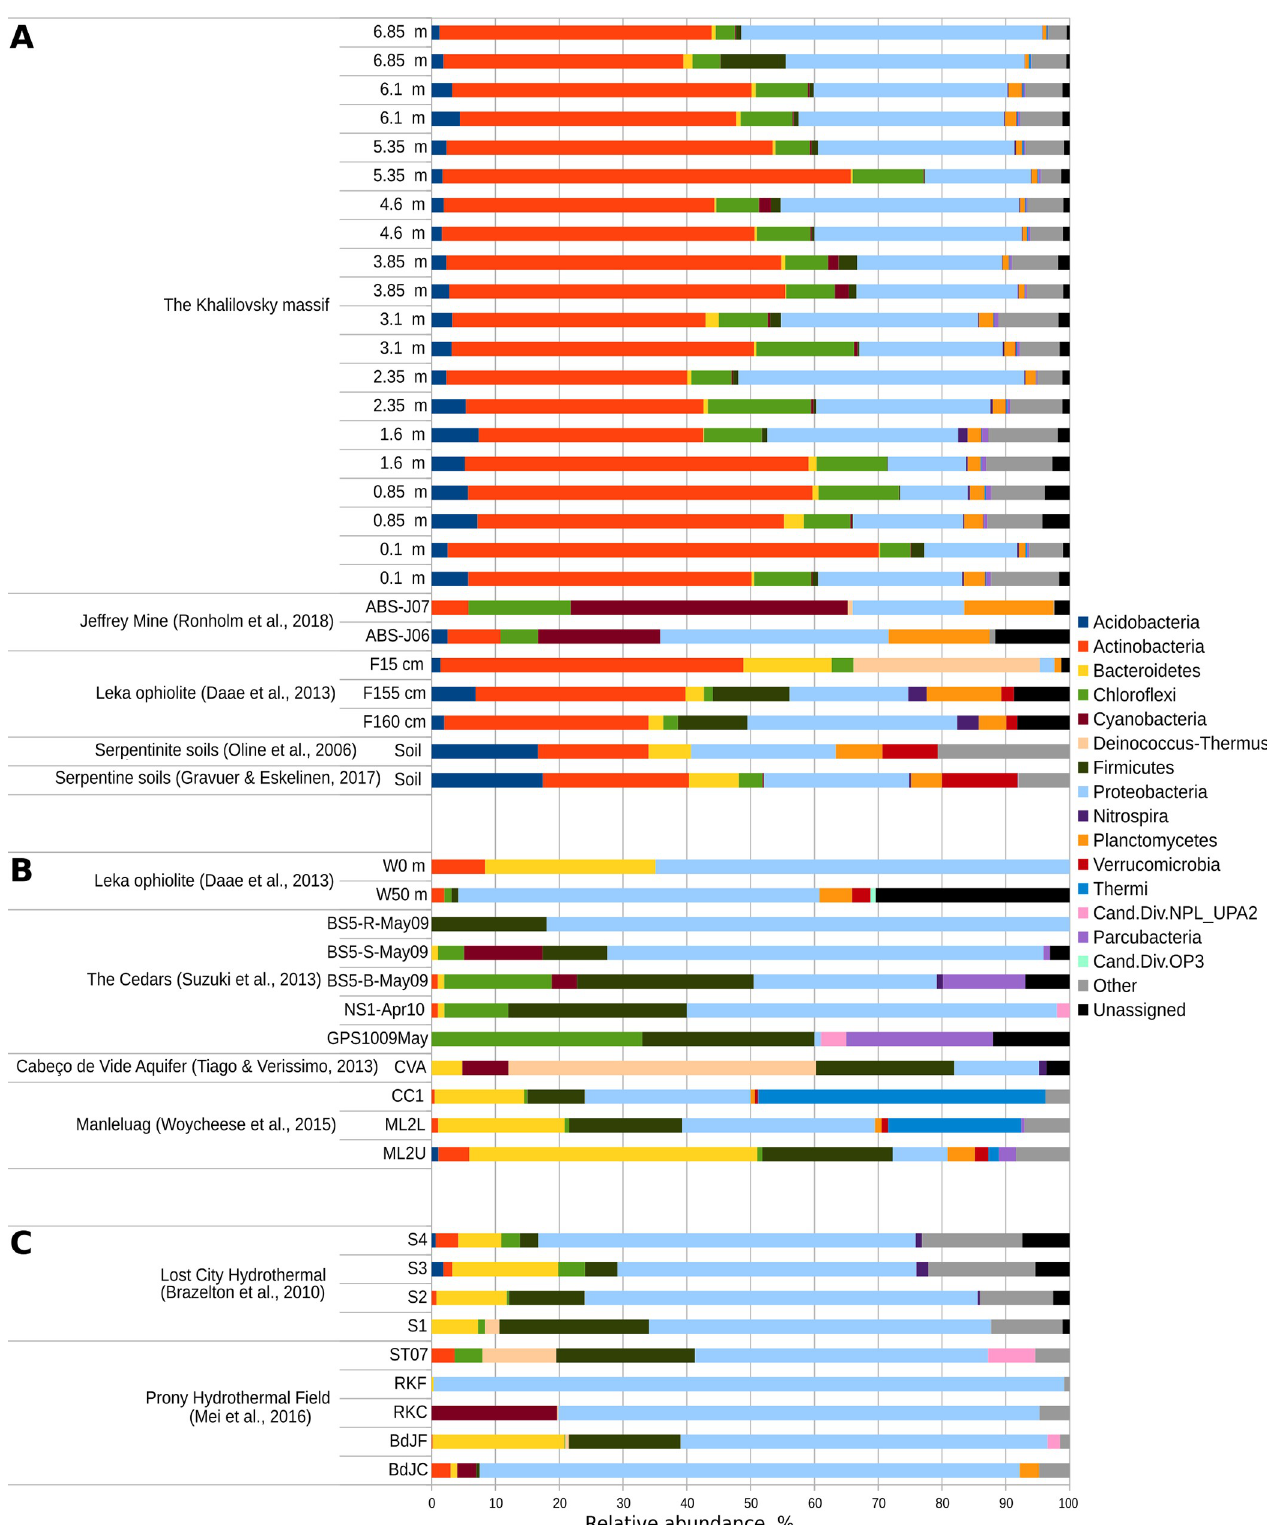
Fig 2. Comparative analysis of mineral- and aqueous-associated serpentine-hosted bacterial communities according to Phylum. ( A ) Community profiles of the Khalilovsky massif compared to those associated with serpentine minerals in other terrestrial environments. ( B , C ) Profiles of selected aqueous- associated planktonic communities from ( B ) terrestrial environments and ( C ) seawater serpentine- and ultramafic-hosted systems [24–32]. https://doi.org/10.1371/journal.pone.0225929.g002 PLOS ONE | https://doi.org/10.1371/journal.pone.0225929 December12, 2019 8 /